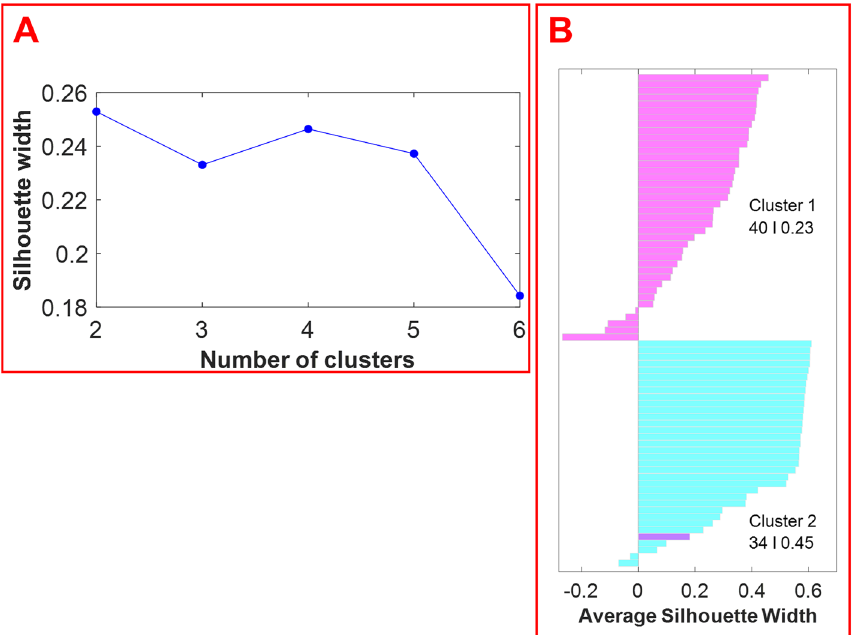
Fig. 4 The average silhouette width over a range of cluster numbers (2–6) reveals that the optimum number of clusters is 2 (panel A ). A silhouette plot (i.e., the visualization of the silhouette width for each sample) reveals the results with two clusters (panel B ). Cluster 1 contains 40 members and cluster 2 contains 34 members. Hemp samples are shown in magenta, while marijuana samples are shown in cyan